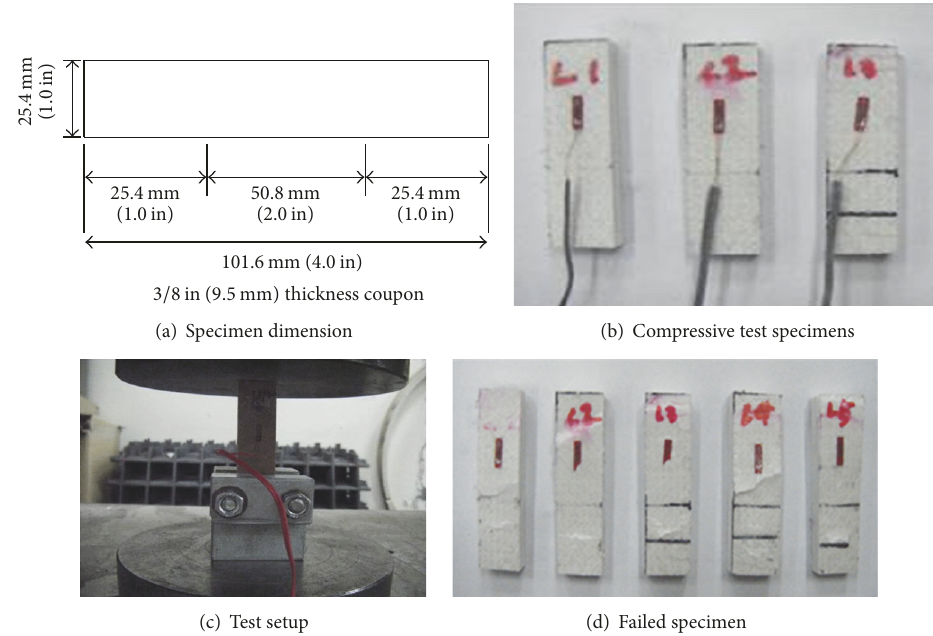
Figure 4: Compression test specimens and test